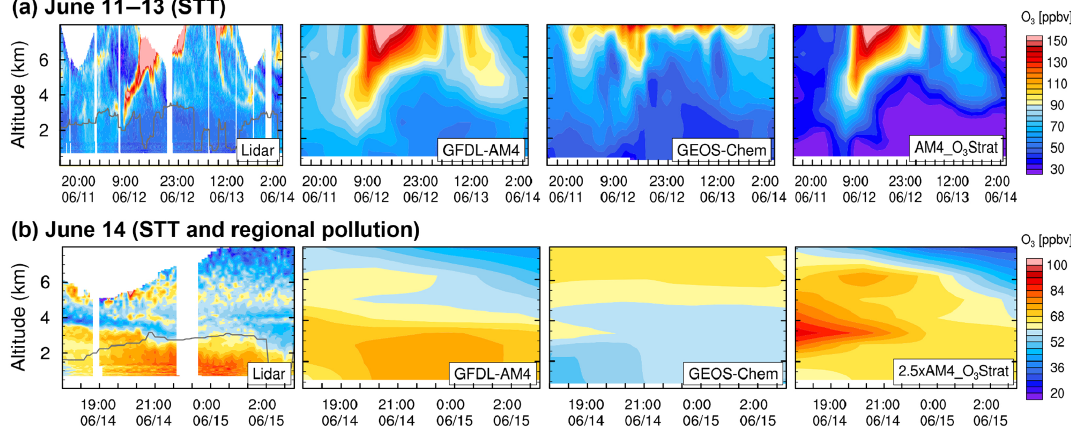
Figure 8. Time–height curtain plots of O 3 above NLVA as observed with TOPAZ lidar and simulated with GFDL-AM4 ( ∼ 50km × 50km; interpolated from 3-hourly data) and GEOS-Chem (0.25 ◦ × 0.3125 ◦ ; interpolated from hourly data) during the STT event on (a) 11–13 June and (b) 14 June 2017 (UTC). The rightmost panel shows the AM4 stratospheric O 3 tracer (AM4_O 3 Strat). Note that AM4 O 3 Strat for 14 June is scaled by a factor of 2.5 for clarity. Here and in other figures, the solid black lines in the O 3 lidar plots represent boundary layer height inferred from the micro-Doppler lidar measurements.